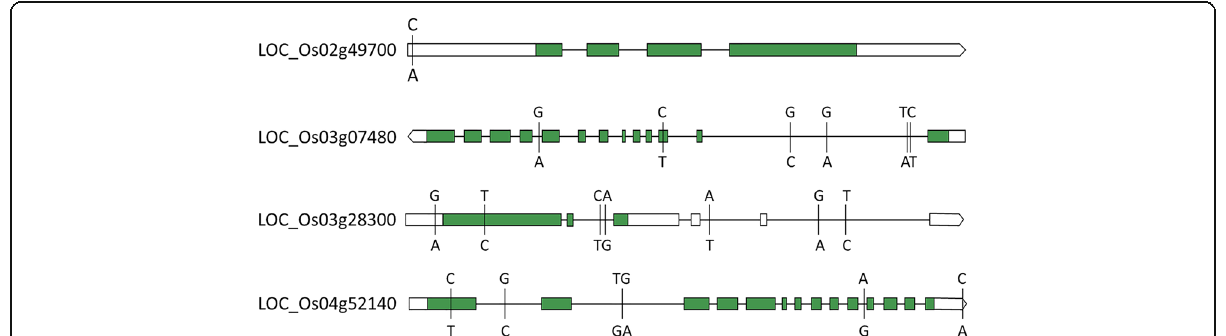
Fig. 5 Predicted structures of the four genes significantly associated with GY and the positions of the SNPs used for haplotype analysis. The green rectangles indicated